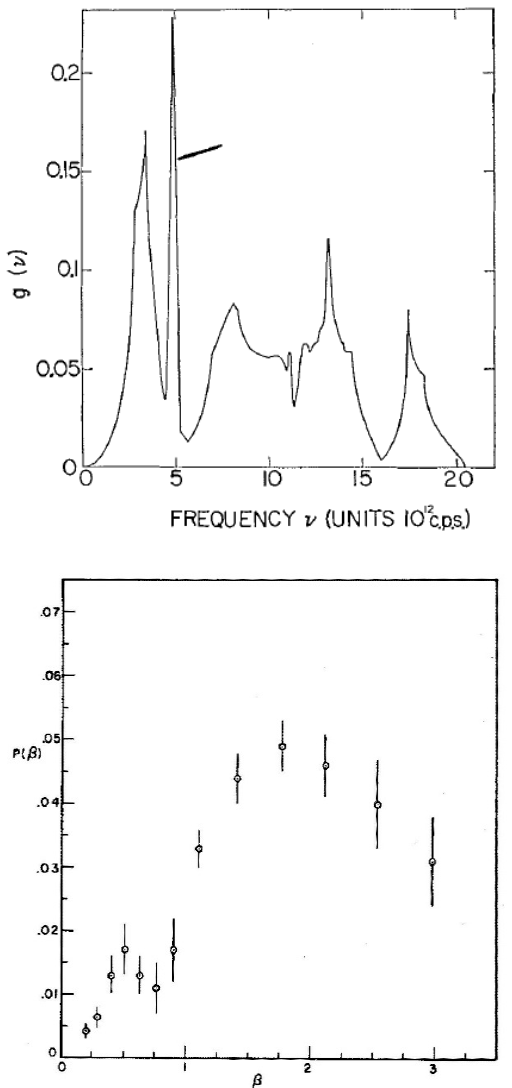
Figure 37. The upper figure is the frequency distribution, g ( υ ), calculated from the best fit shell model for UO 2 [58]. The statistical fluctuations in the curve, which is a histogram plot, are too small to be shown in the figure. The upper figure is taken from Figure 5 of ref. [58] courtesy of Canadian Science Publishing and its licensors. p ( β ) is derived from time-of-flight polycrystalline measurements on UO 2 via the scattering law and is taken from Figure 5 of ref. [93] courtesy of the IAEA.